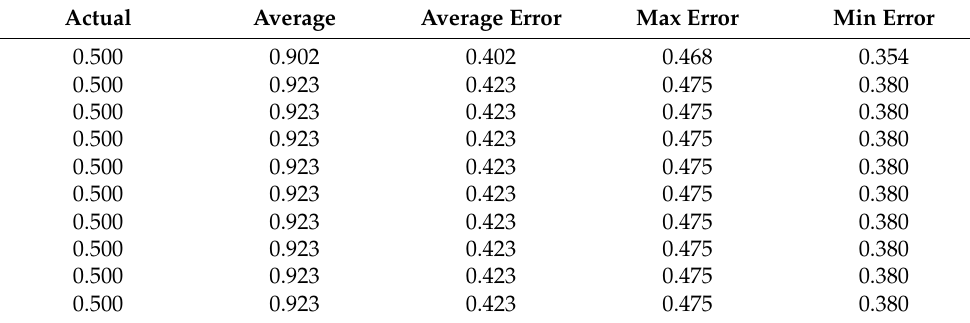
Table A97. Set 2, trials 11–20 data (all 0.5 PR values).